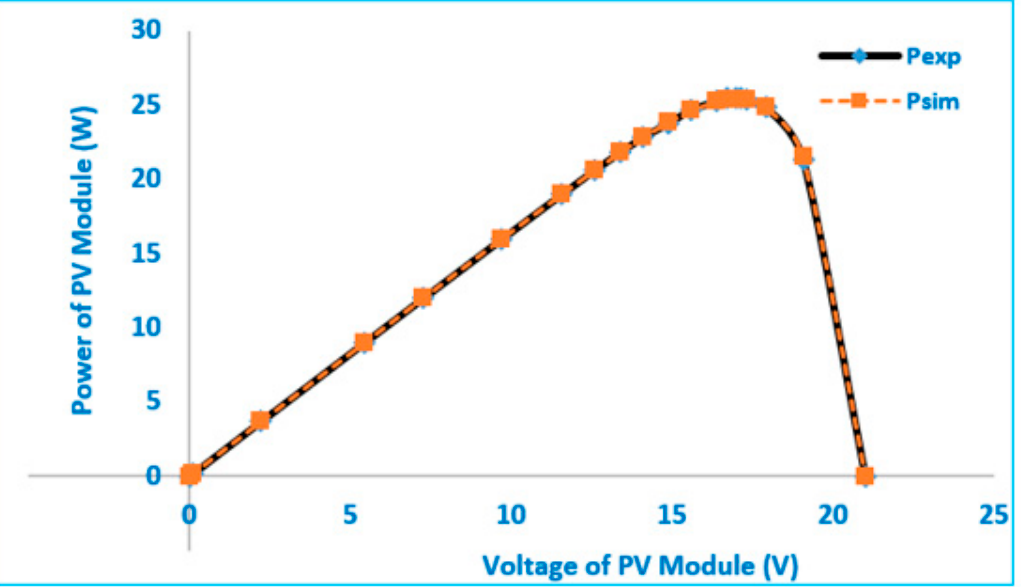
Figure 7. P–V characteristics of the proposed HPO technique for the single-diode STM6_40/36 PV module.